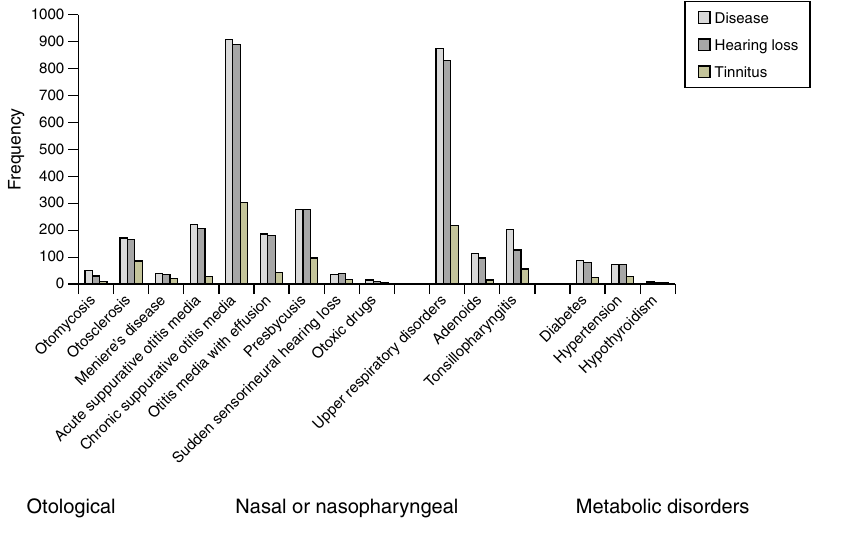
Figure 1 Prevalence of tinnitus and hearing loss in otological diseases.